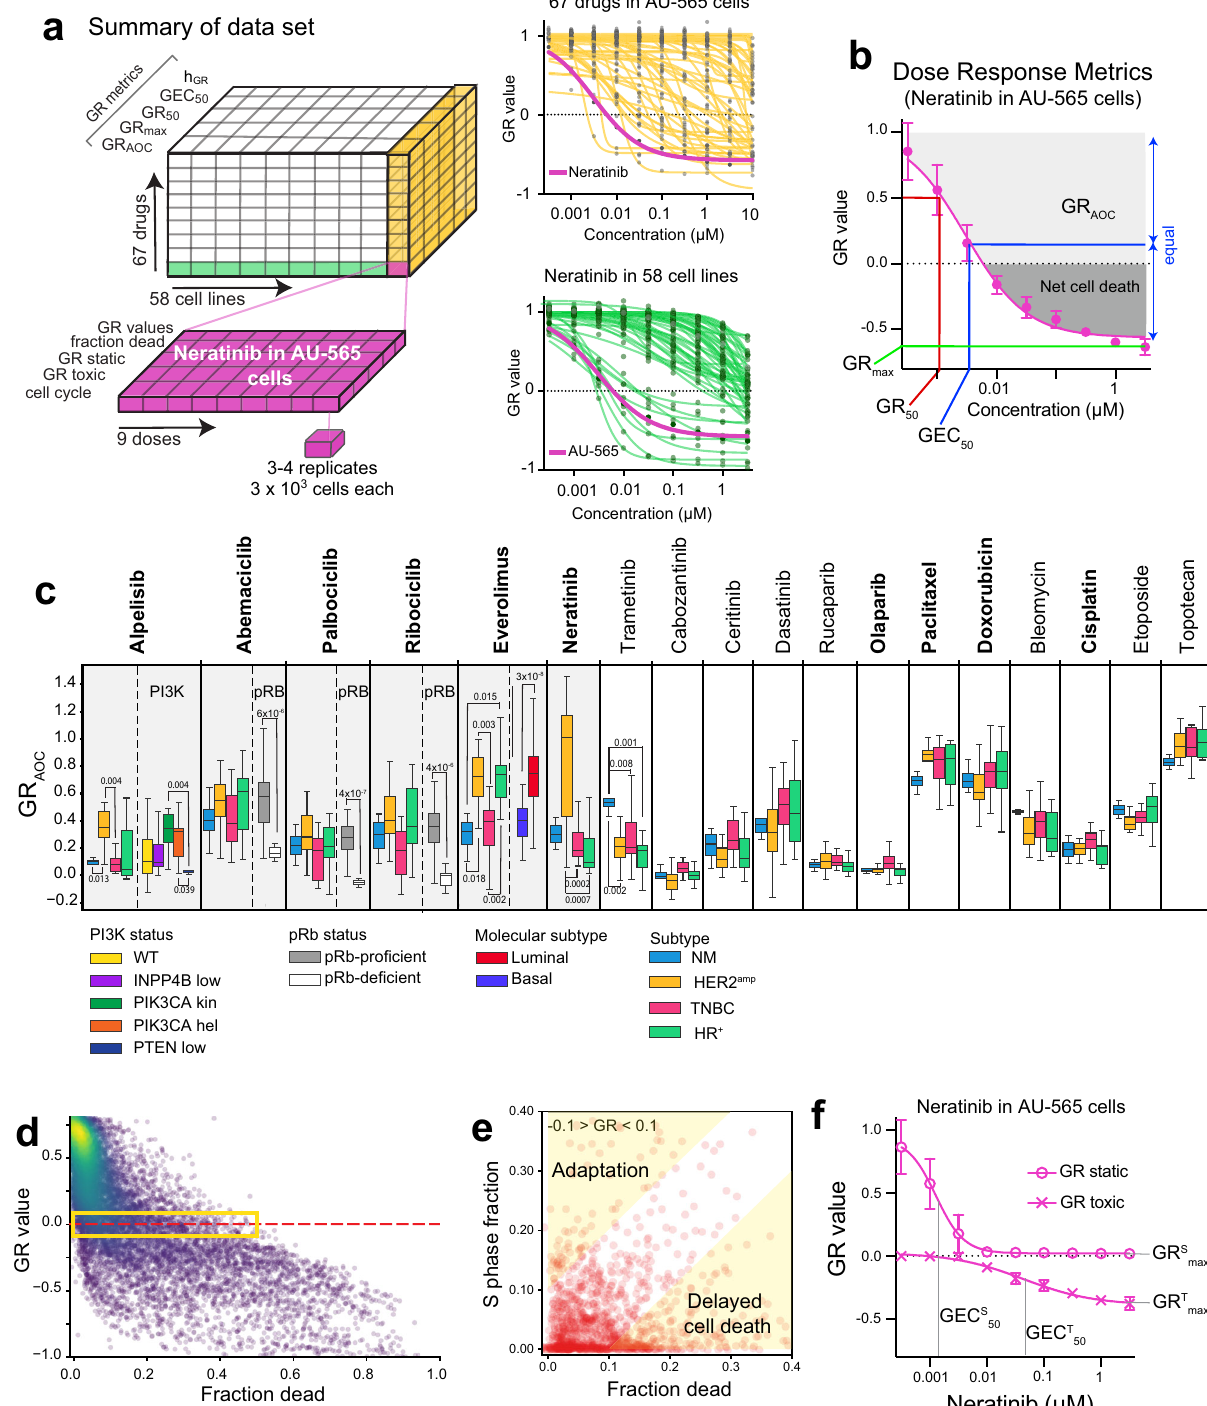
Fig.4|DyeDropscreeningofabreastcancercelllinepaneltreatedwithakinase inhibitor library. a Dye Drop and Deep Dye Drop assays were used to measure the responsesof58breastcancercelllinestreatedwith67drugsatnineconcentrations after 72h in technical triplicate or quadruplicate. GR-dose response curves for all drugsinAU-565cellsandallcelllinestreatedwithneratinib.TheresponseofAU-565 cellstoneratinibisshowninpink.Errorbarsareomittedforsimplicity. b Illustration of GR metrics shown on the neratinib-AU-565 dose-response curve. Data are pre- sented as mean +/ − standard deviation of technical quadruplicates. c Boxplot of GR AOC valuesforFDA-approveddrugsincludedinourscreen.Celllinesareseparated by clinical subtype ( n = 5 NM, 13 HER2 amp , 13 HR + , 26 TNBC), dose responses were measured in technical triplicate or quadruplicate. The bottom and top of the box